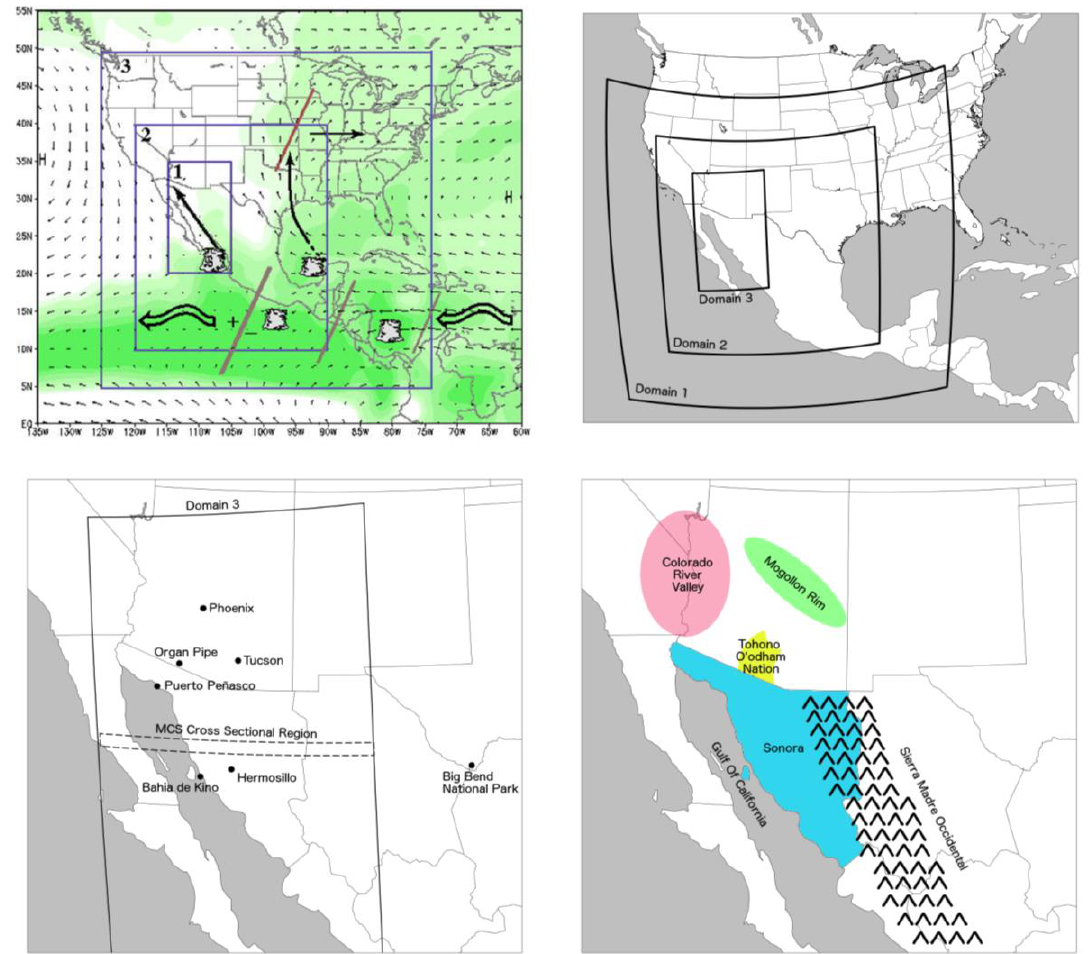
Figure 1. Illustrative maps of the North American monsoon region under study. ( Top left ) North American Monsoon Experiment tier domains (Figure 1 from [51] © American Meteorological Society. Used with permission). ( Top right ) WRF model domains used for simulation, with model grid spacing of 30, 10, and 2.5 km corresponding to domains 1, 2, and 3. ( Bottom left) WRF domain 3 zoomed in, with the locations of cities and landmarks referenced within the text. The areas used to compute the cross section of a simulated MCS during NAME IOP 2 indicated. ( Bottom right ) Some key geographic areas referenced within the text.